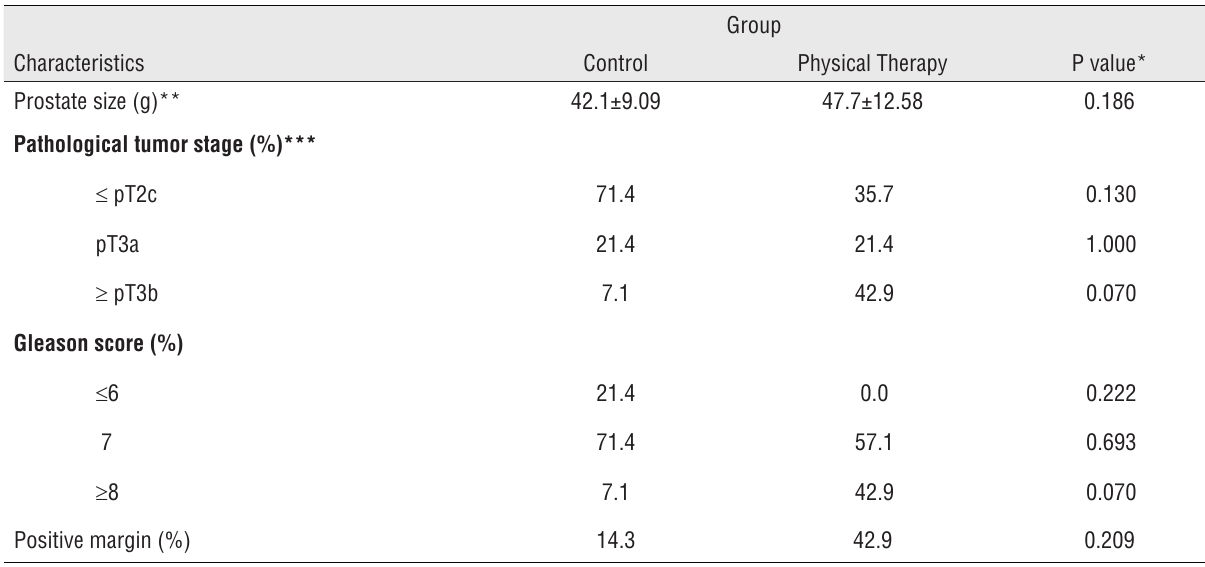
Table 2 - Tumor stage and pathological features of prostate cancer in patients undergoing radical prostatectomy and submitted (Physical Therapy Group) or not submitted (Control Group) to pelvic floor muscle training for recovery of urinary continence and erectile function.